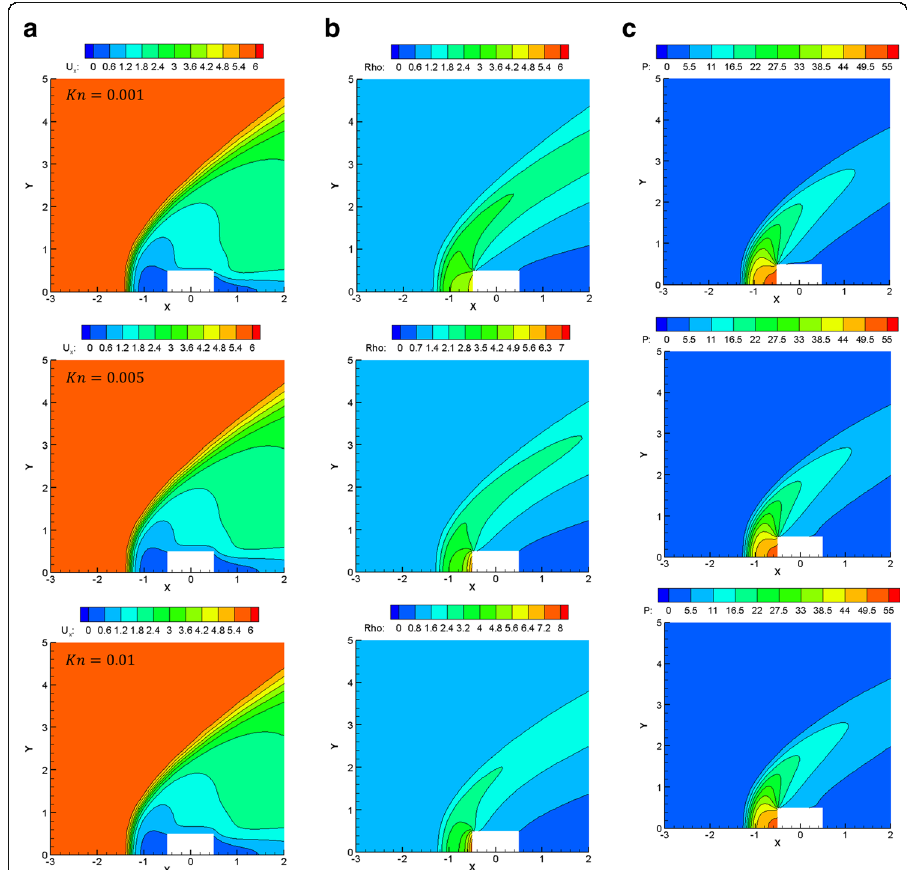
Fig. 9 Contour plots of normalized conserved variables for different Knudsen numbers (0.001, 0.005, and 0.01), plotted in rows, at M = 6: a U x velocity, b density, and c